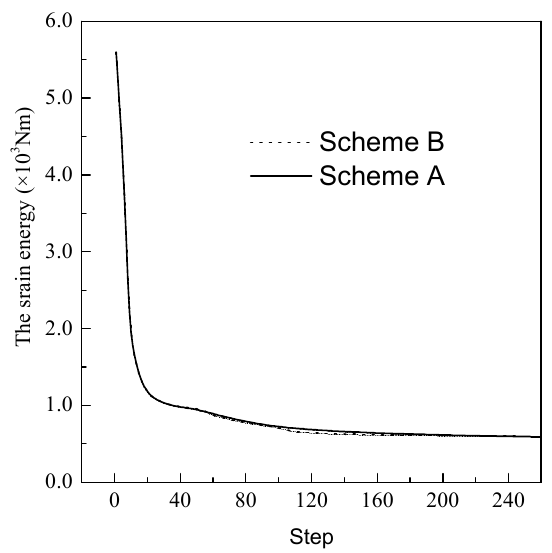
Figure 6. The change ratio of the strain energy of Schemes A and B.